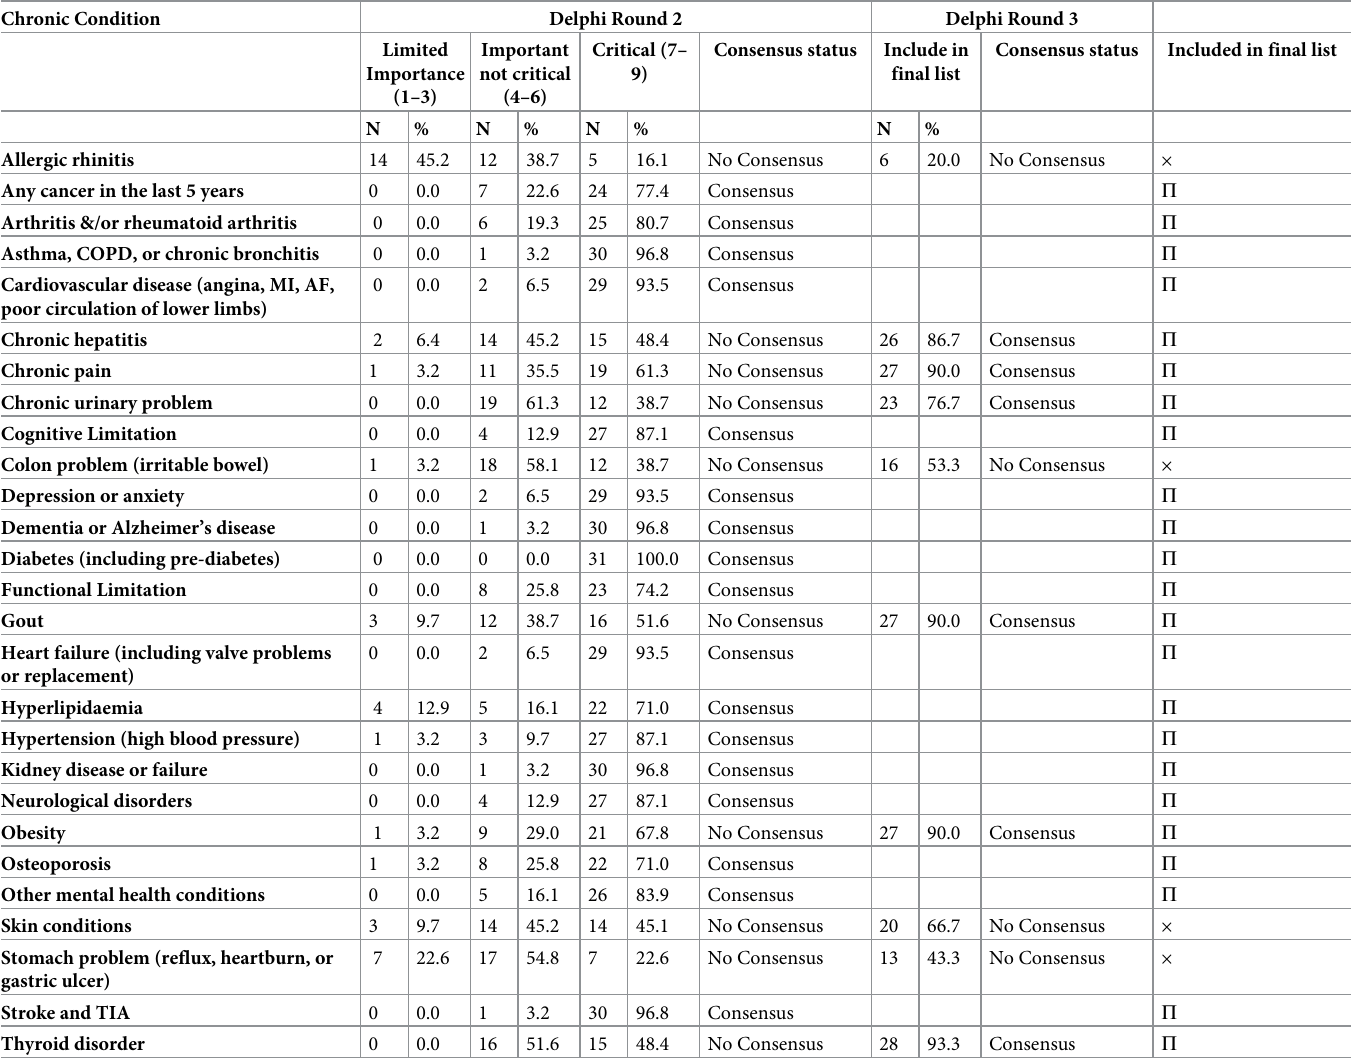
Table 5. Findings for list of chronic conditions for defining